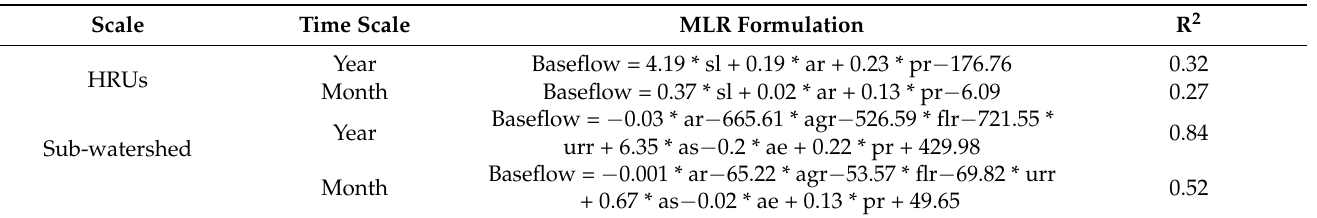
Table 5. MLR formulation for different spatiotemporal scales and the R 2 of these formulations. The monthly results were analyzed based on all months; the meaning of the variables is defined in Table